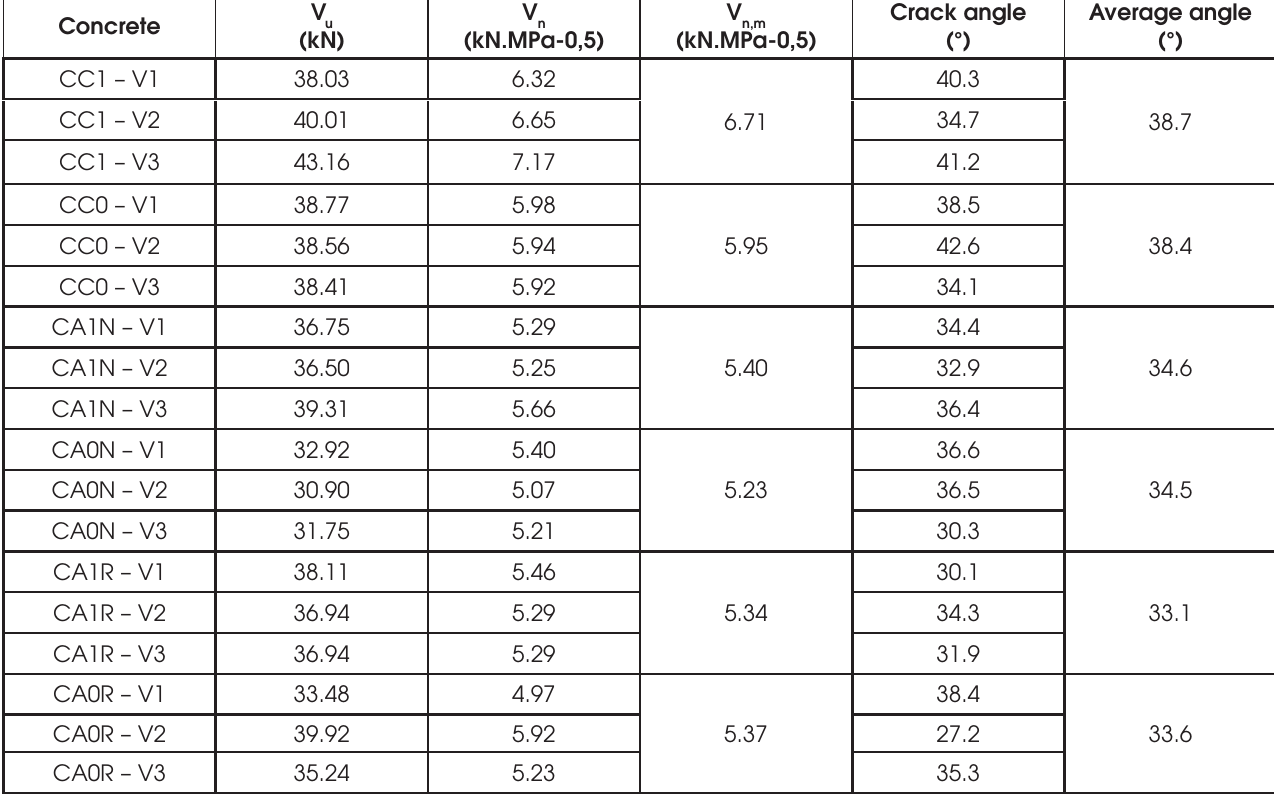
Ultimate shear capacity, normalized and average value, and shear crack inclination angle Concrete